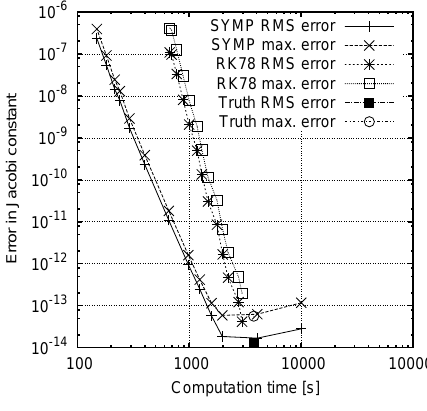
Fig. 11. The root mean square and maximum errors in the Jacobi constant.